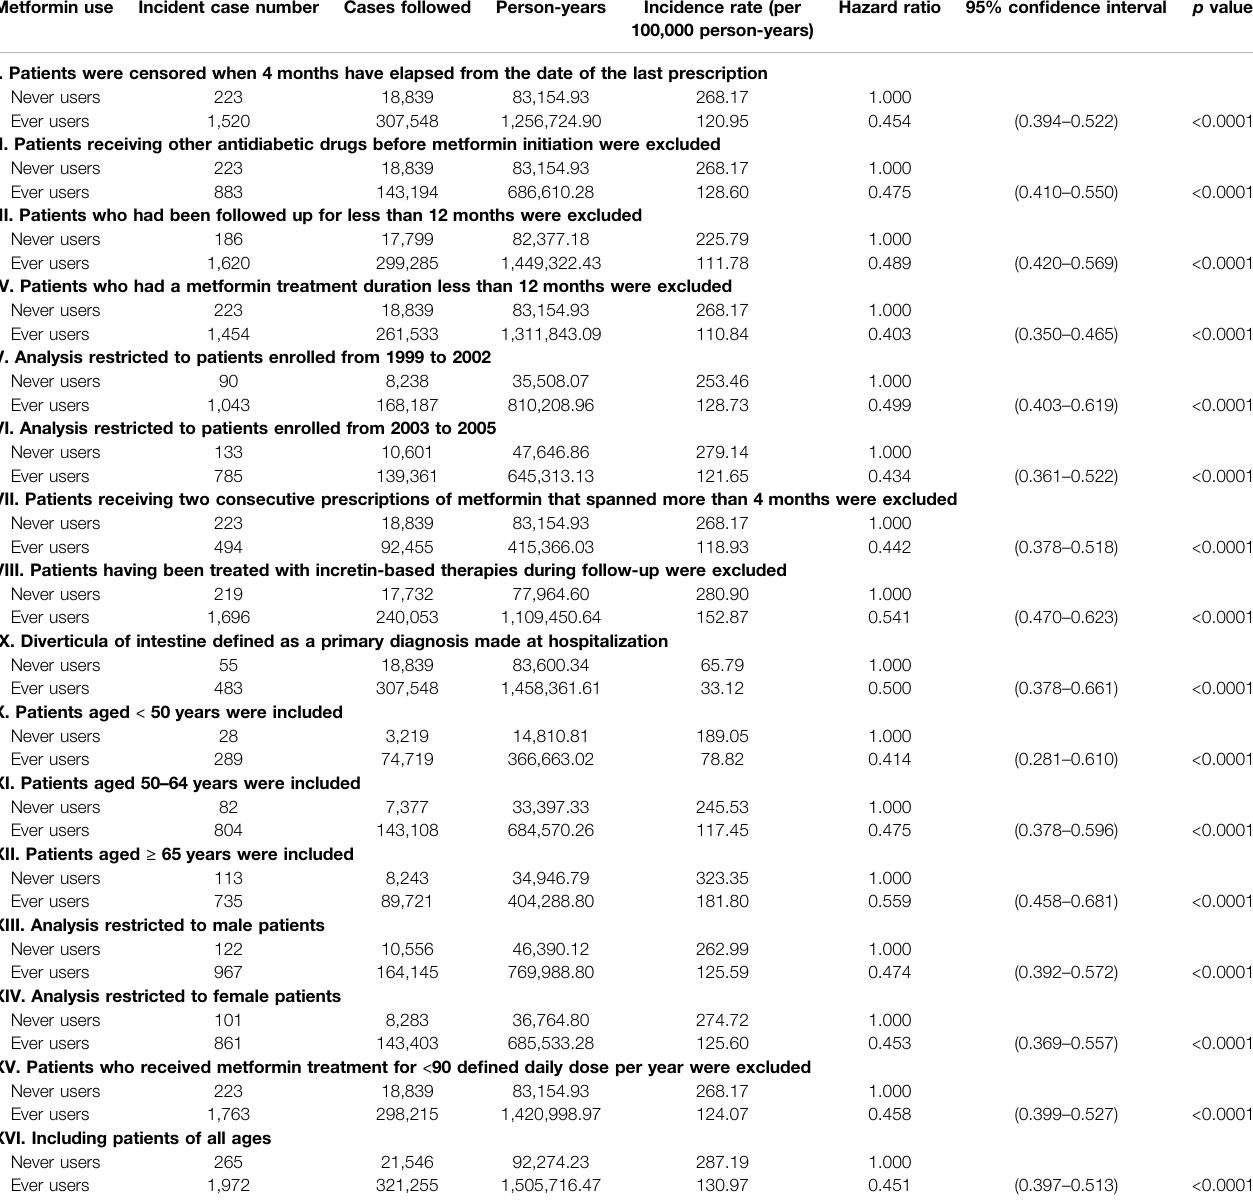
TABLE 3 | Sensitivity